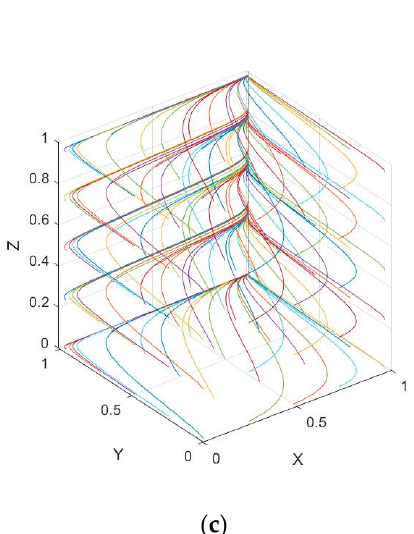
Figure 3. Dynamic simulation results after adjusting the adjustable variables: ( a – c ) represents dynamic trajectories of strategy changes of (0,0,0), (1,0,0), and (1,1,1), under 125 rounds dynamic simulations corresponding to 1/4 step size conditions.